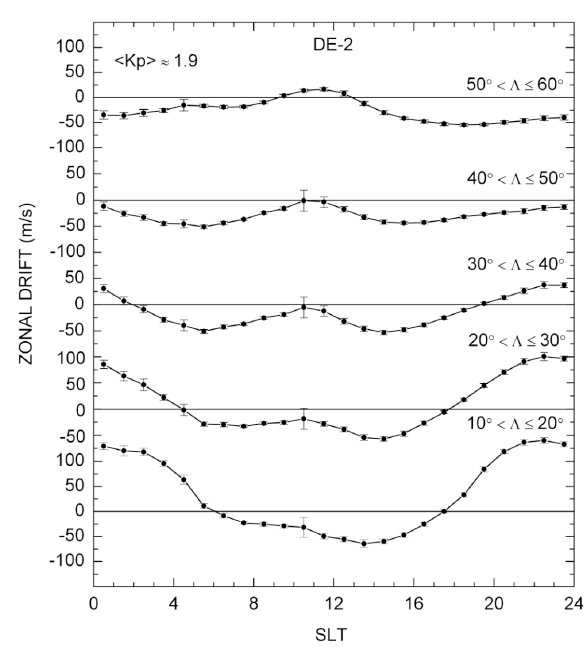
Figure 3 Fig. 4. Longitudinal variations of early night northern and southern hemisphere quiet-time average relative zonal drift velocities in five longitudinal